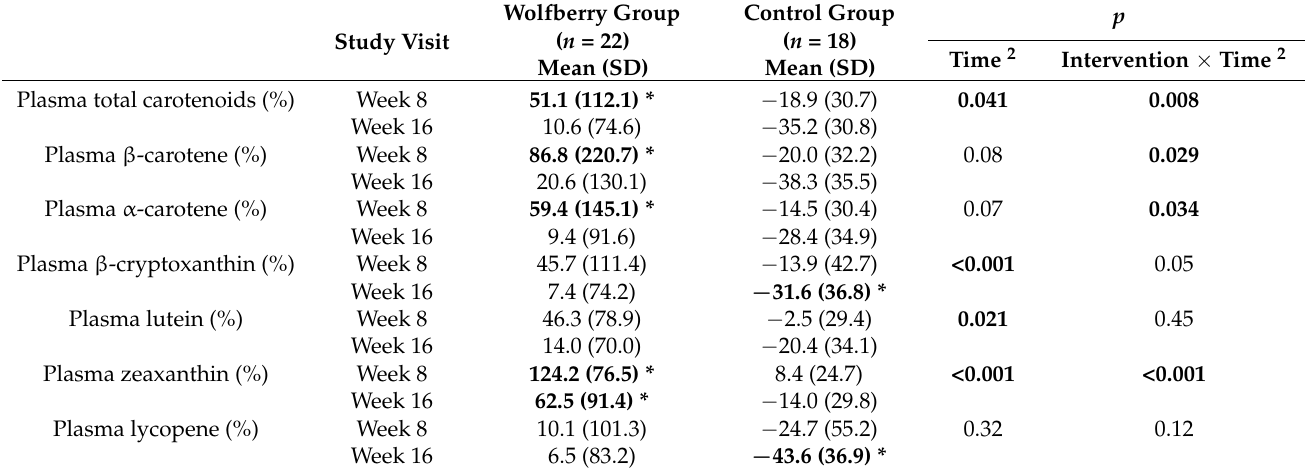
Table 1. Changes in plasma carotenoids status at weeks 8 and 16 of randomized controlled trial 1.